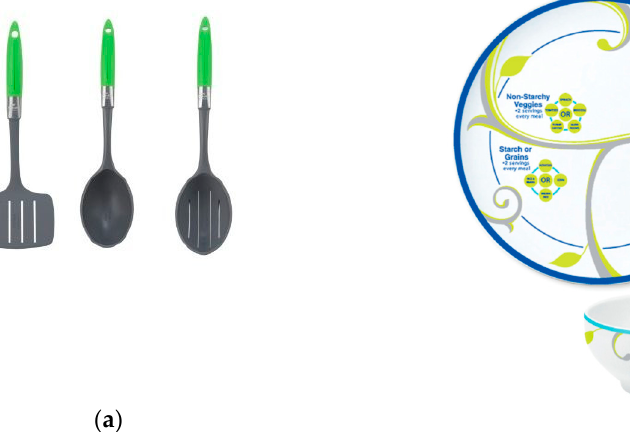
Figure 1. Portion-control tools used to explore the experiences of 29 individuals with obesity trying to manage their weight. ( a ) The set of plastic serving utensils included a serving spoon with capacity for 1 portion of starch (0.5 cup), a serving spoon for 1 portion of vegetables (0.5 cup cooked, 1 cup raw), and a serving spatula for 1 portion of protein (2.5 oz.), based on the USDA standards (source: HealthySteps ™ [19]). ( b ) The crockery set included a 9-inch plate decorated with leaves depicting 3 sectors and labels to indicate food types (non-starchy vegetables, protein, and starch) in each sector; a crockery bowl with disguised marks for 0.5 cup, 1 cup, 1.5 cup; and a clear, tall glass with disguised marks for 4 oz. and 8 oz. (source: Precise Portions Nutrition Learning System [18]).